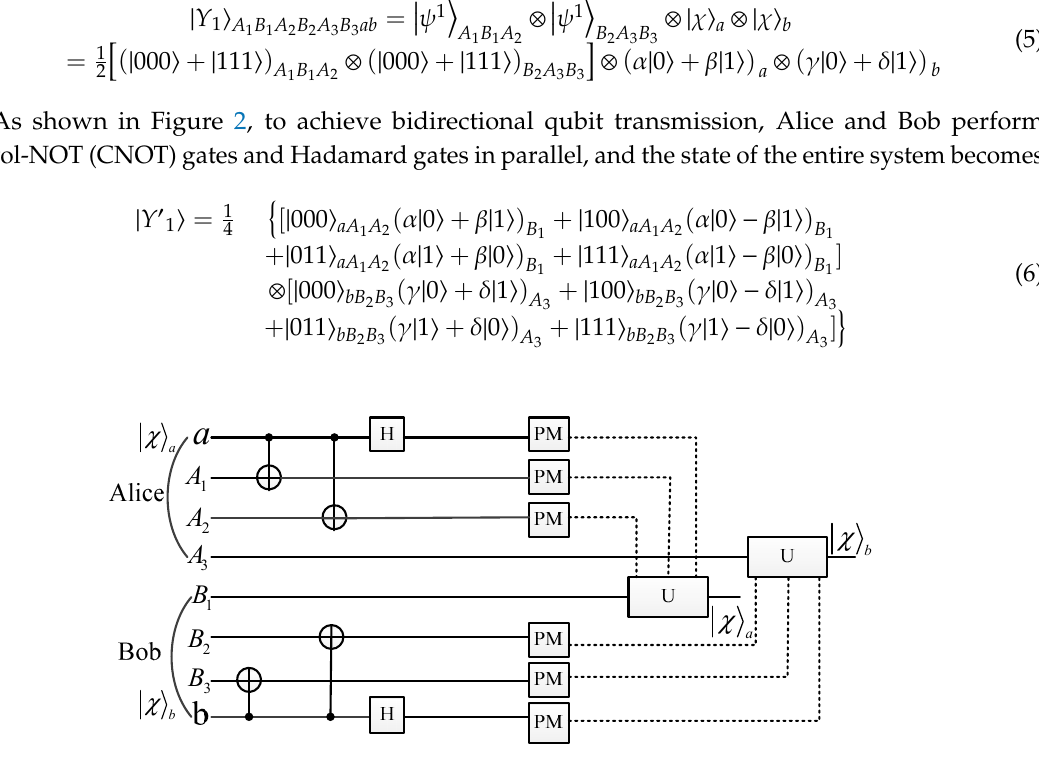
Figure 2. Quantum circuit for one-hop bidirectional quantum communication, where the dashed lines represent classical channels and the solid lines represent quantum channels.